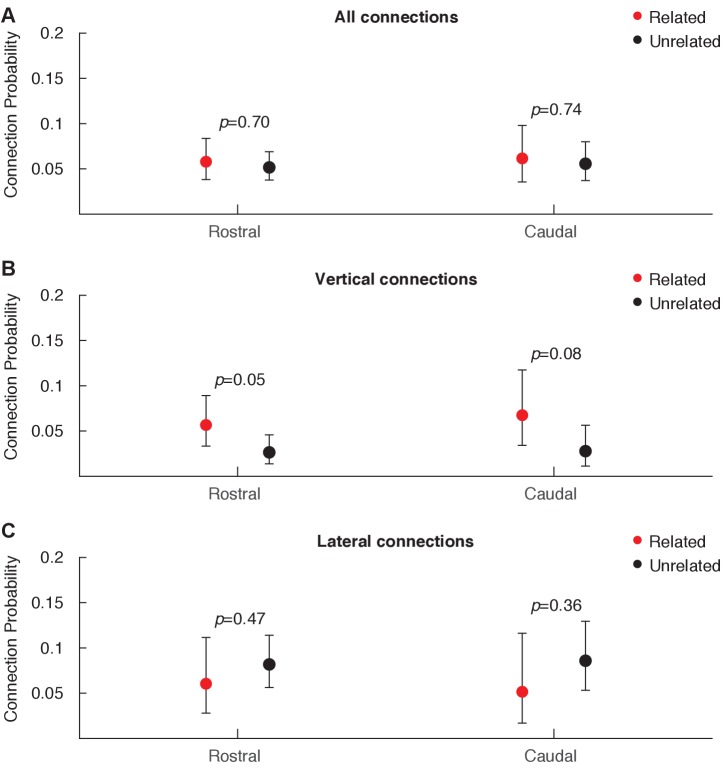
Connectivity differences between clonally related and unrelated neurons in different rostrocaudal positions.(A) Connection probabilities for all connection types tested, grouped by rostrocaudal position (n = 449 and 260 related pairs and n = 833 and 485 unrelated pairs in rostral and caudal groups, respectively). (B) Connection probabilities for all vertical, across-layer connections tested, grouped by rostrocaudal position (n = 300 and 163 related pairs and n = 454 and 252 unrelated pairs in rostral and caudal groups, respectively). (C) Connection probabilities for all lateral, within-layer connections tested, grouped by rostrocaudal position (n = 149 and 97 related pairs and n = 379 and 233 unrelated pairs in rostral and caudal groups, respectively). Error bars are 95% Clopper-Pearson confidence intervals and p-values are computed using Fisher’s exact test. Related to Figure 5.